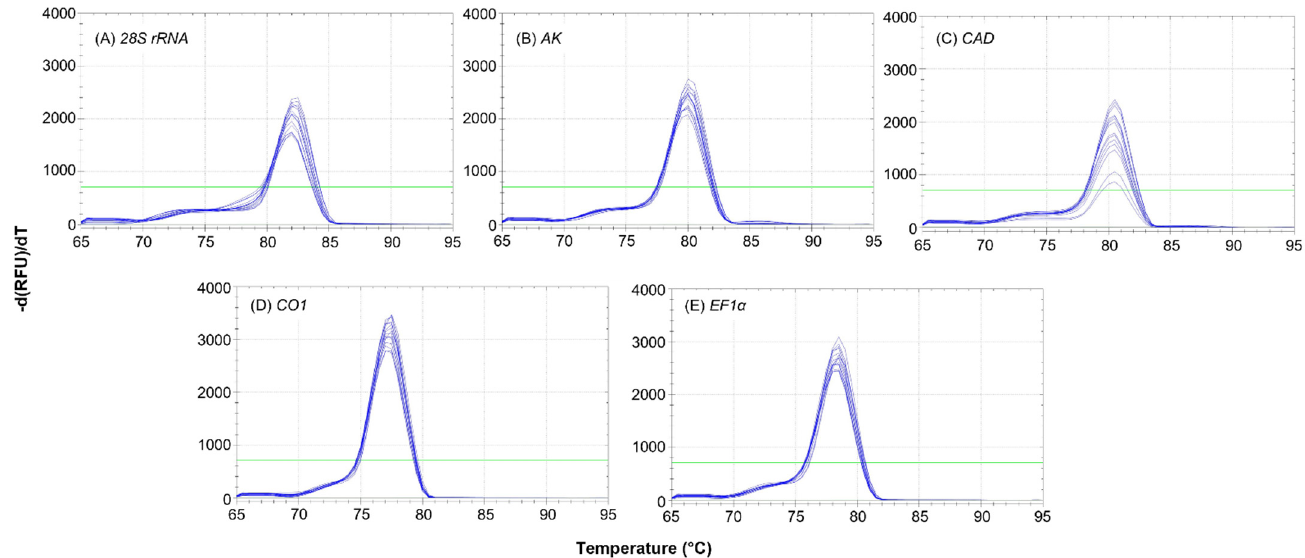
Figure 2. Melt curves demonstrating the presence of a single peak to rule out non-specific products following RT-qPCR reactions for the following primers ( A ) 28S rRNA , 28S ribosomal RNA; ( B ) AK , arginine kinase; ( C ) CAD , carbamoyl- phosphate synthetase 2-aspartate transcarbamylase-dihydroorotase, ( D ) CO1 , cytochrome oxidase subunit 1, and ( E ) EF1 α , elongation factor 1- α . Horizontal green line represents baseline threshold.